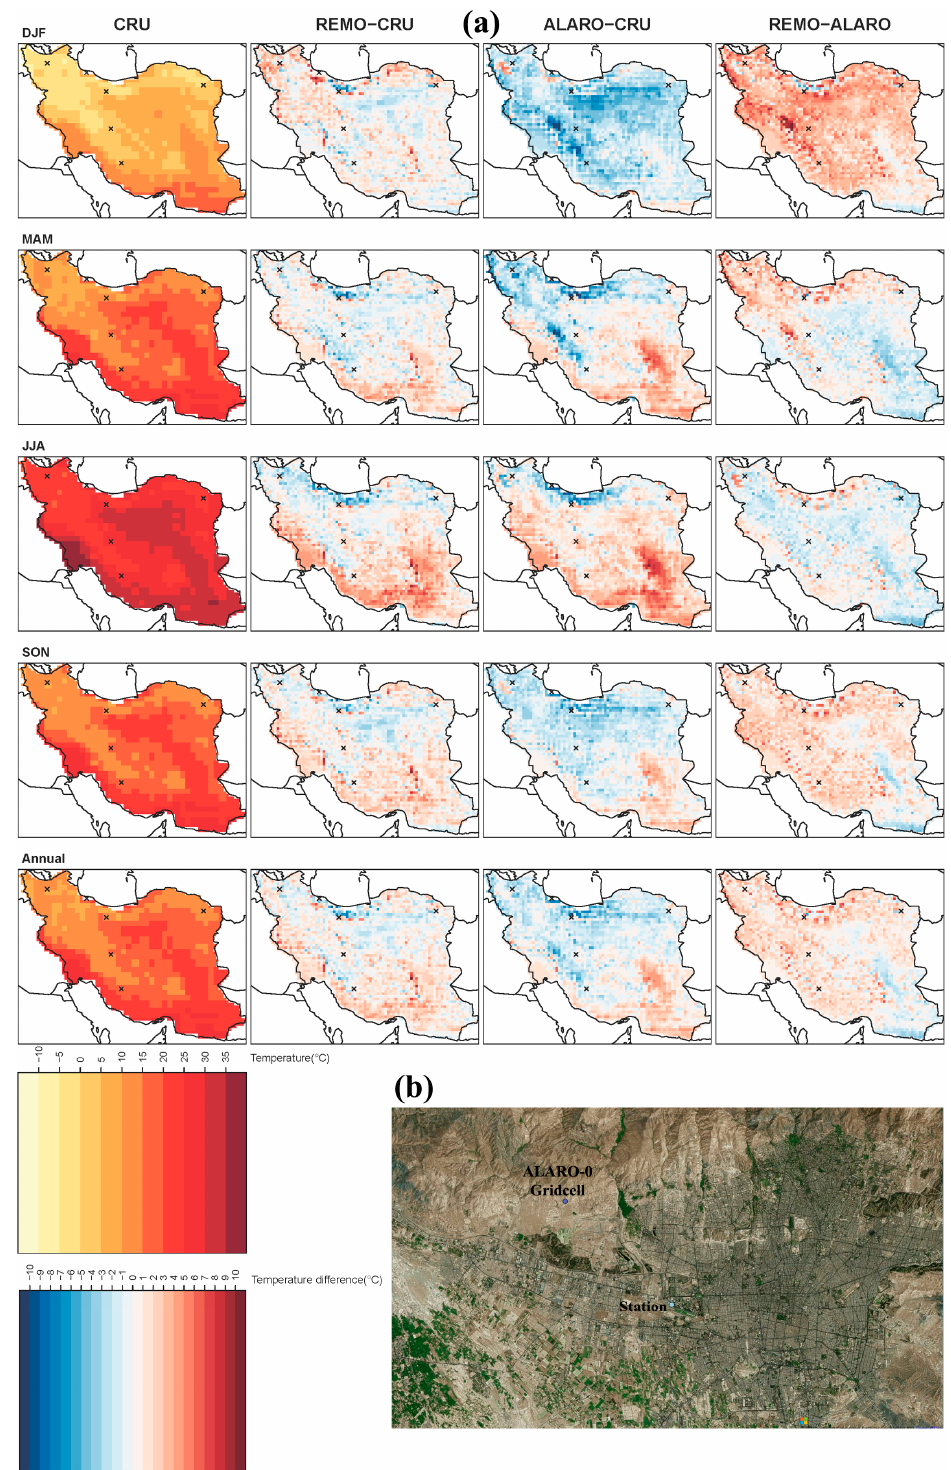
Figure 4. ( a ) Spatial representation of temperature over Iran based comparing CRU observational gridded dataset and bias for REMO and ALARO-0 compared to CRU at 0.22 °. A very cold bias just above the cross of Tehran is highlighted with dark blue. ( b ) Aerial map of Tehran comparing measurement station (light blue) coordinations with ALARO-0 gridcell (purple).